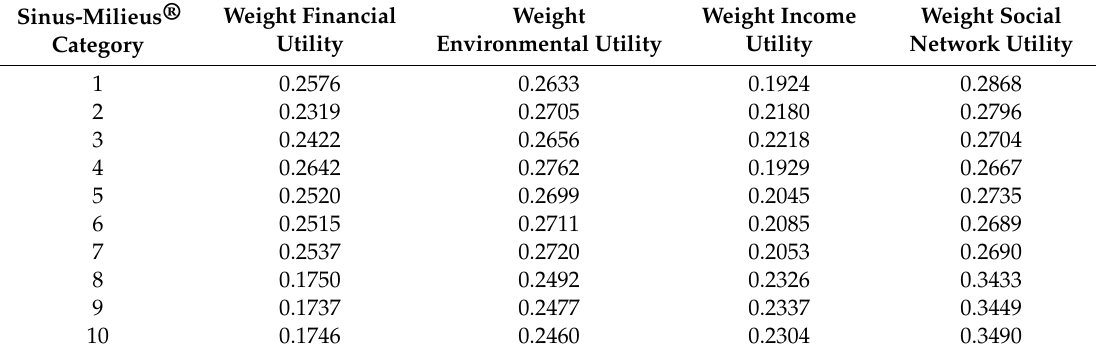
Table A12. Calibrated weights of each partial utility and decision threshold per Sinus-Milieus ® category.